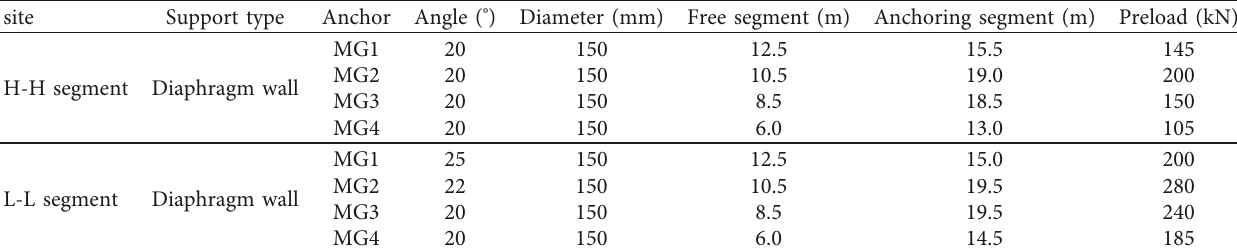
Table 2: The prestressed anchor design